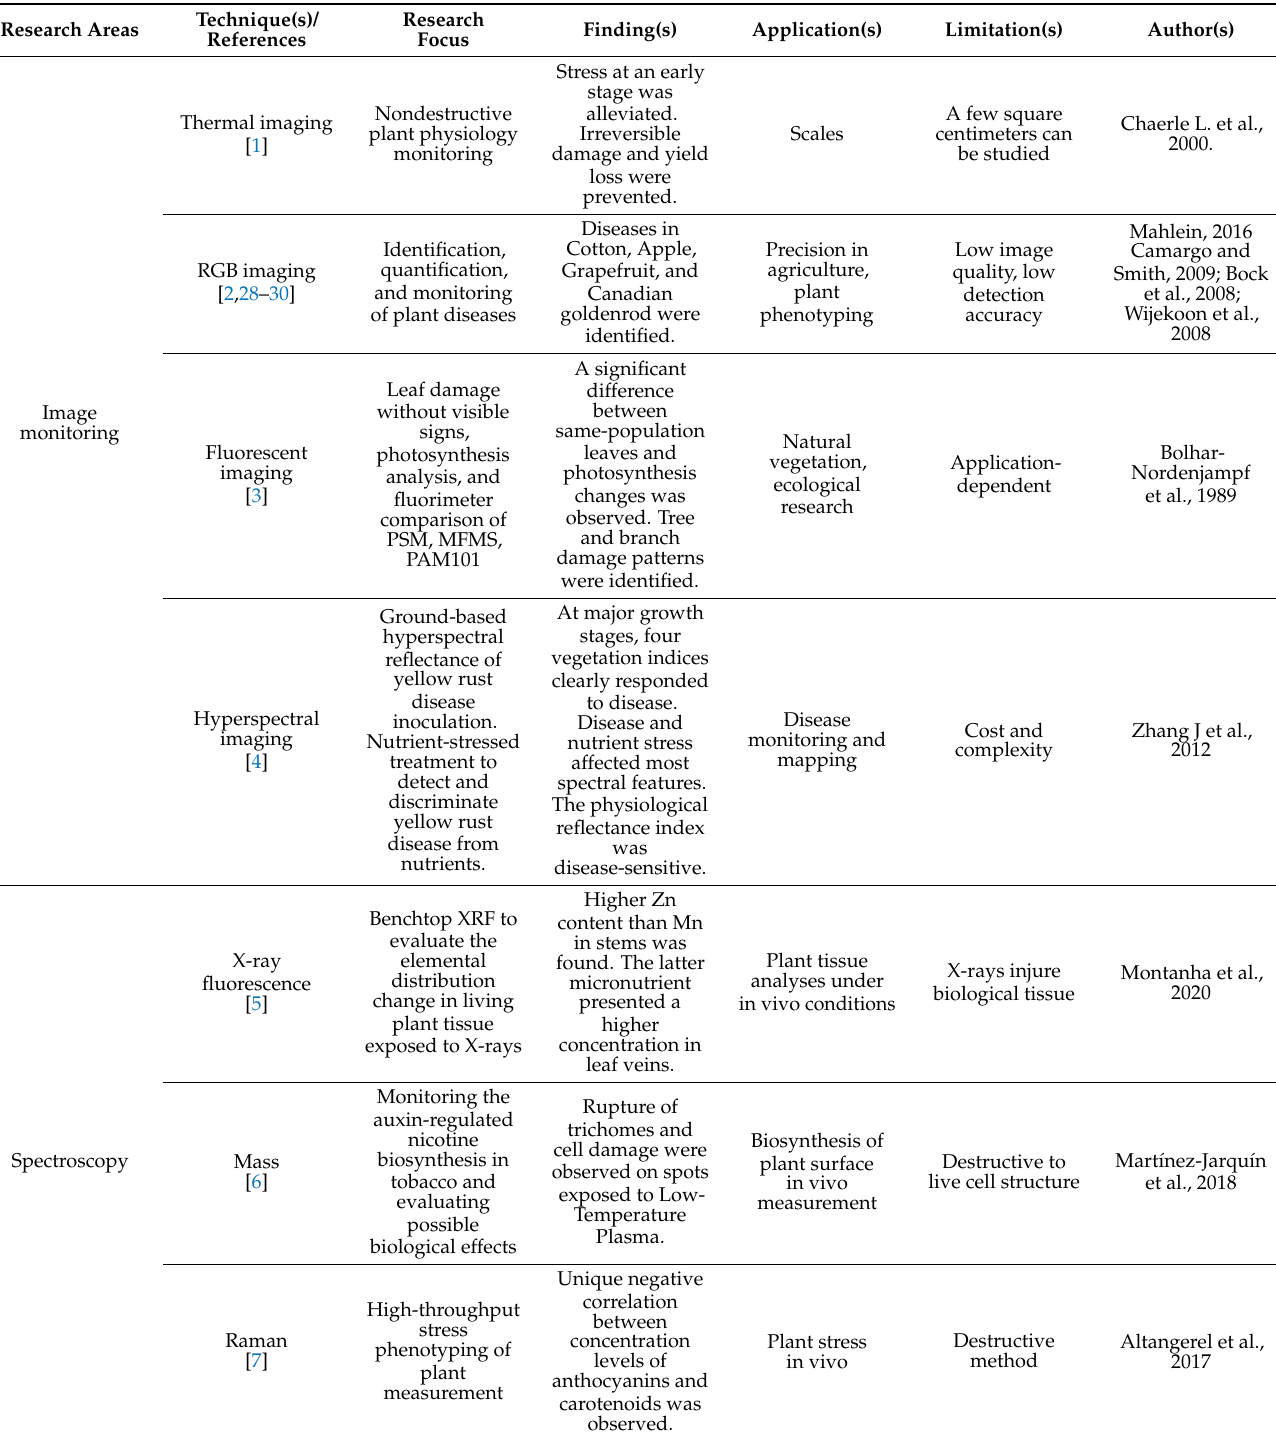
Table 1. A brief overview of the